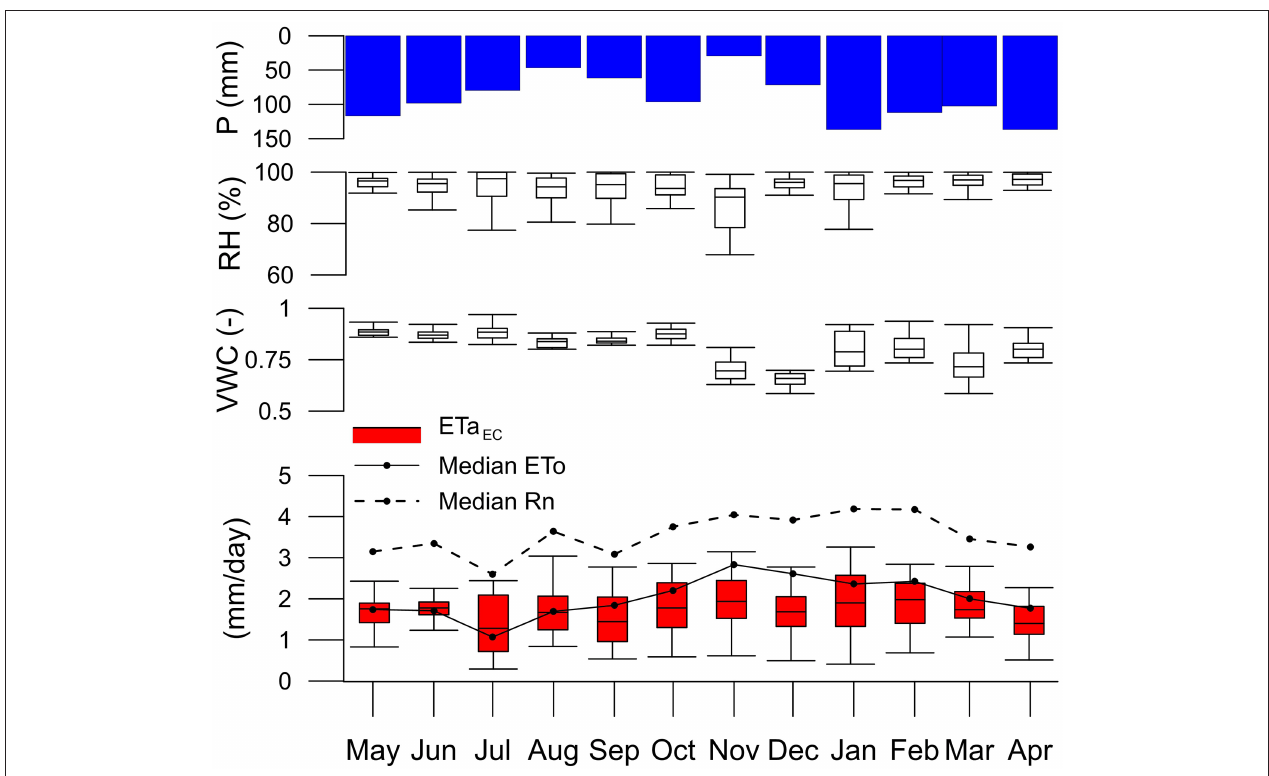
FIGURE 3 | Daily actual evapotranspiration measured with the eddy-covariance method (ETa EC in mm/day) shown for every month together with the median potential evapotranspiration (ETo in mm/day) estimated with the Penman-Monteith equation and median net radiation (Rn in mm/day). Additionally, monthly precipitation ( P in mm/month), soil volumetric water content (VWC), and relative humidity (RH in percentage) are shown.